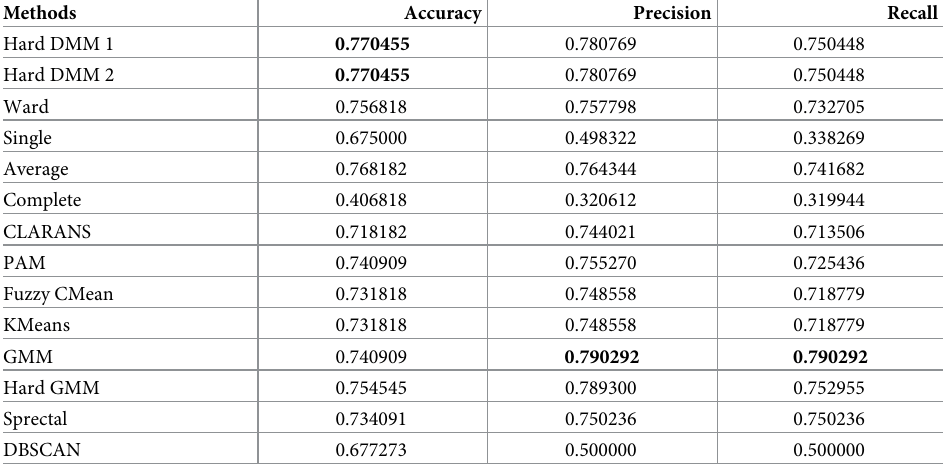
Table 5. Performance comparison of different model based clustering methods on wholesale customers data.